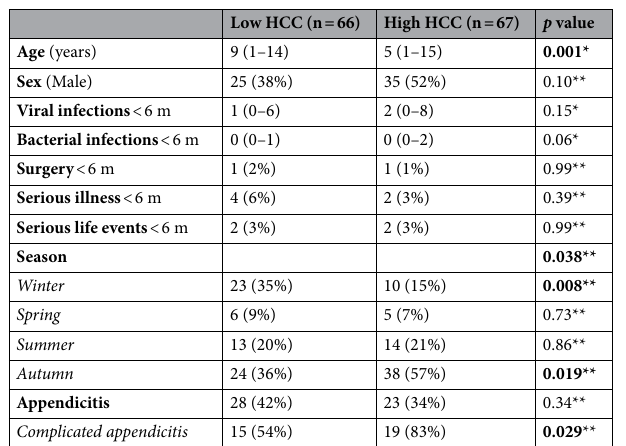
Table 1. Level of hair cortisol concentration in 51 patients with appendicitis and 82 healthy controls. Values presented as median (min–max) or as absolute number (percentage of patients/controls); HCC: hair cortisol concentration; Low HCC < 22.96 pg/mg (median), high HCC ≥ 22.96 pg/mg; *Mann–Whitney U-test, **Chi- squared test.